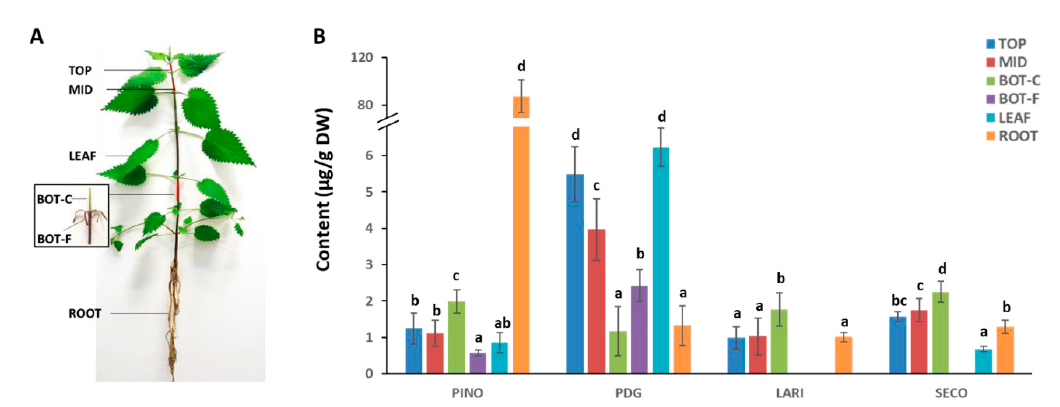
Figure 5. ( A ) Tissues and organs collected for analyses. TOP, MID, BOT-C, BOT-F, LEAF and ROOT represent the top and middle internode, core and cortical tissue of bottom internode, leaves and roots, respectively. ( B ) Content (in µg/g DW) of each lignan in different tissues. The targeted quantification of pinoresinol (PINO), pinoresinol diglucoside (PDG), lariciresinol (LARI), secoisolariciresinol (SECO) was performed using LC-HRMS. Error bars represent the standard deviation calculated from four independent biological replicates and two technical replicates. Significant differences among groups were analysed using one-way ANOVA followed by Tukey’s post-hoc test and are indicated with different letters.